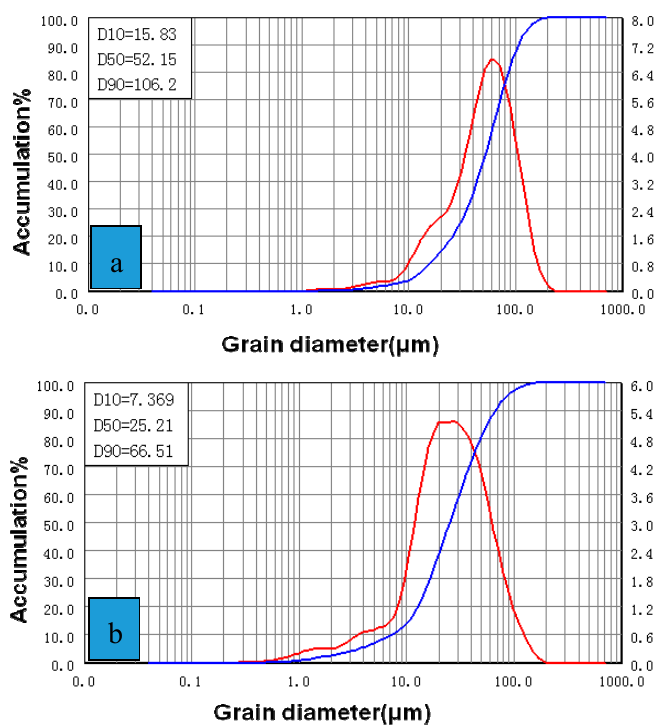
Figure 6. Particle size distribution of the rhenium samples. a —Sample was prepared with the NH 4 ReO 4 crystals without recrystallization. b —Sample was prepared by the recrystallization NH 4 ReO 4 crystals at 200 rpm. The red line represents particle size ( µ m), and the blue line represents the accumulation. Table 4. Specific surfaces and D50s of the rhenium powders.